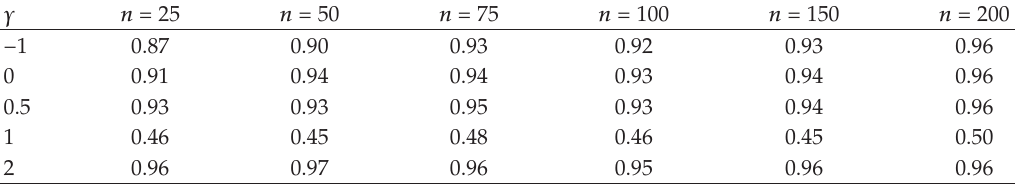
Table 6: Empirical coverage probabilities for the normal distribution, B (cid:6) 1000.